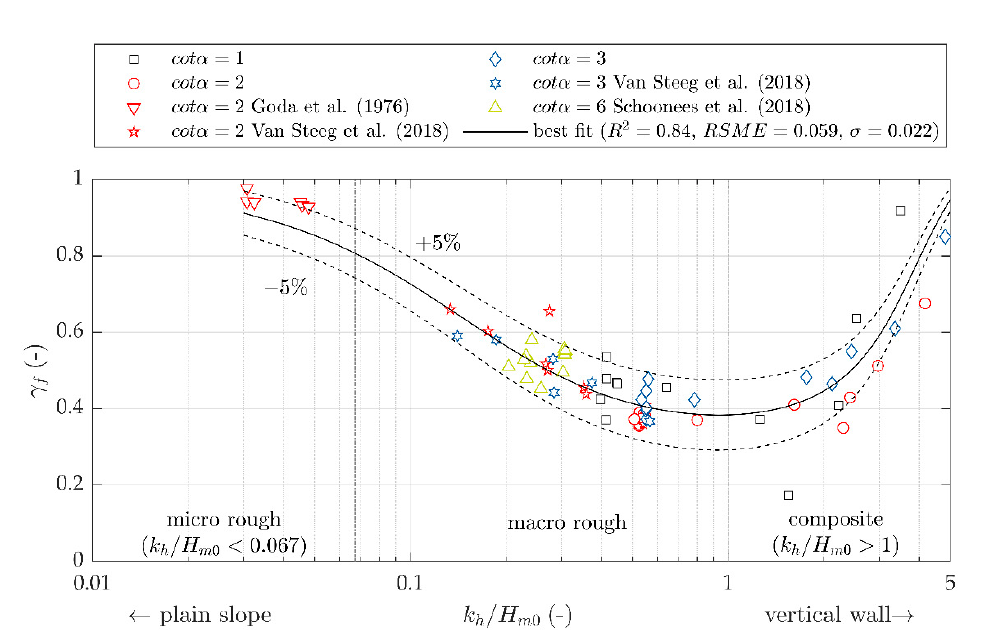
Figure 3. Reduction coe ffi cient γ f versus the step ratio ( k h / H m 0 ) for varying slopes ( 1 ≤ cot α ≤ 6 ) including a best fit regression line and the 90% confidence band.